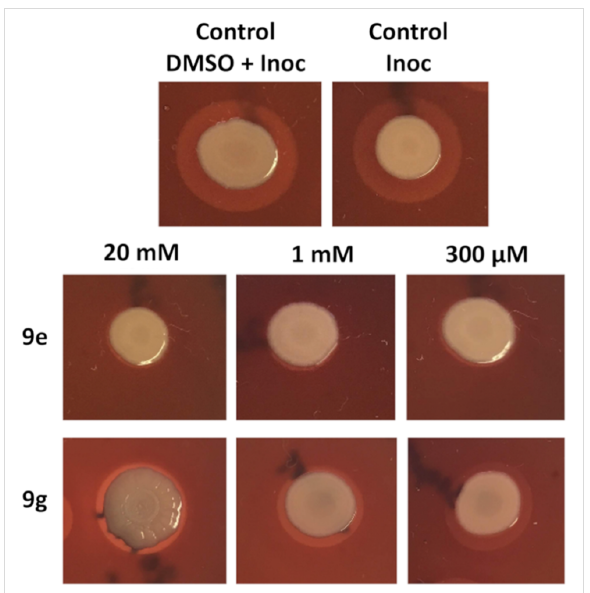
Figure 2: Effect of compounds 9e and 9g at three concentrations on the hemolysis production by S. aureus ATCC 25923 (Assay 2, Inoc